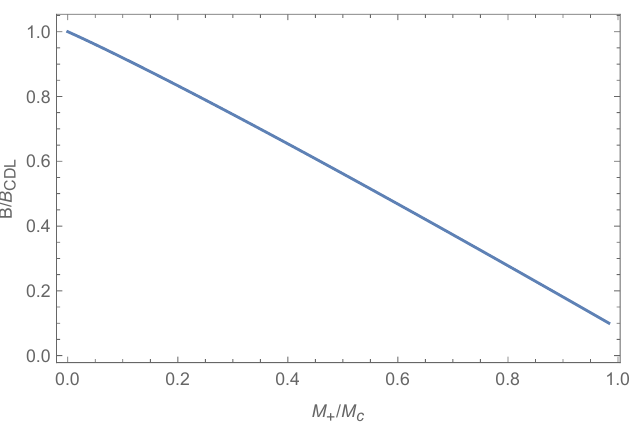
Figure 2 . The ratio of the tunneling coefficient B with B CDL of the bubble nucleation in Schwarzschild black hole as the function of M + /M c . In this plot, G = 1 , L − = 1 , σ = 1 and M c = 0 . 00967